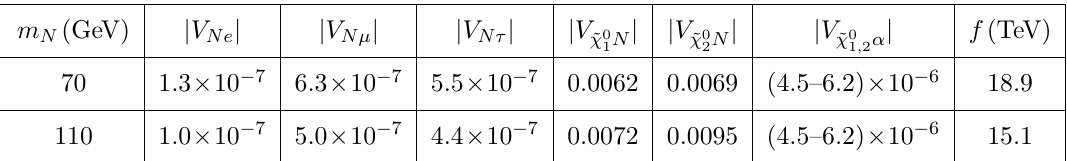
Table 1 . Values of the mixing angles between the active and sterile neutrinos ( V Nα ,α = e,µ,τ ), be- tween the lightest neutralinos and the sterile neutrino ( V ), and between the lightest neutralinos ˜ χ 0 1 , 2 N and the active neutrinos ( V ), computed in the maximal mixing case (formulae (3.17), (3.22)– ˜ χ 0 1 , 2 α (3.23) and (3.25)–(3.26)) for m N = 70GeV and 110GeV , respectively. Also indicated is the value of the global symmetry breaking scale f